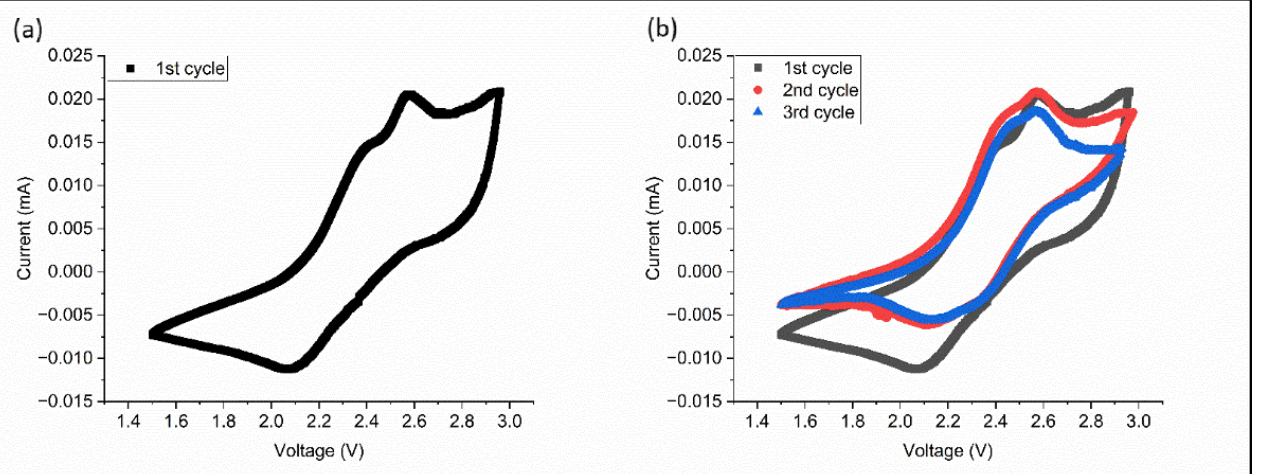
Figure 4. Specific capacity vs. cycle number of the SPNWL, Ni/W = 1:1 and the SPNWL, Ni/W = 9:1. The cells were operated under C/10 at room temperature.